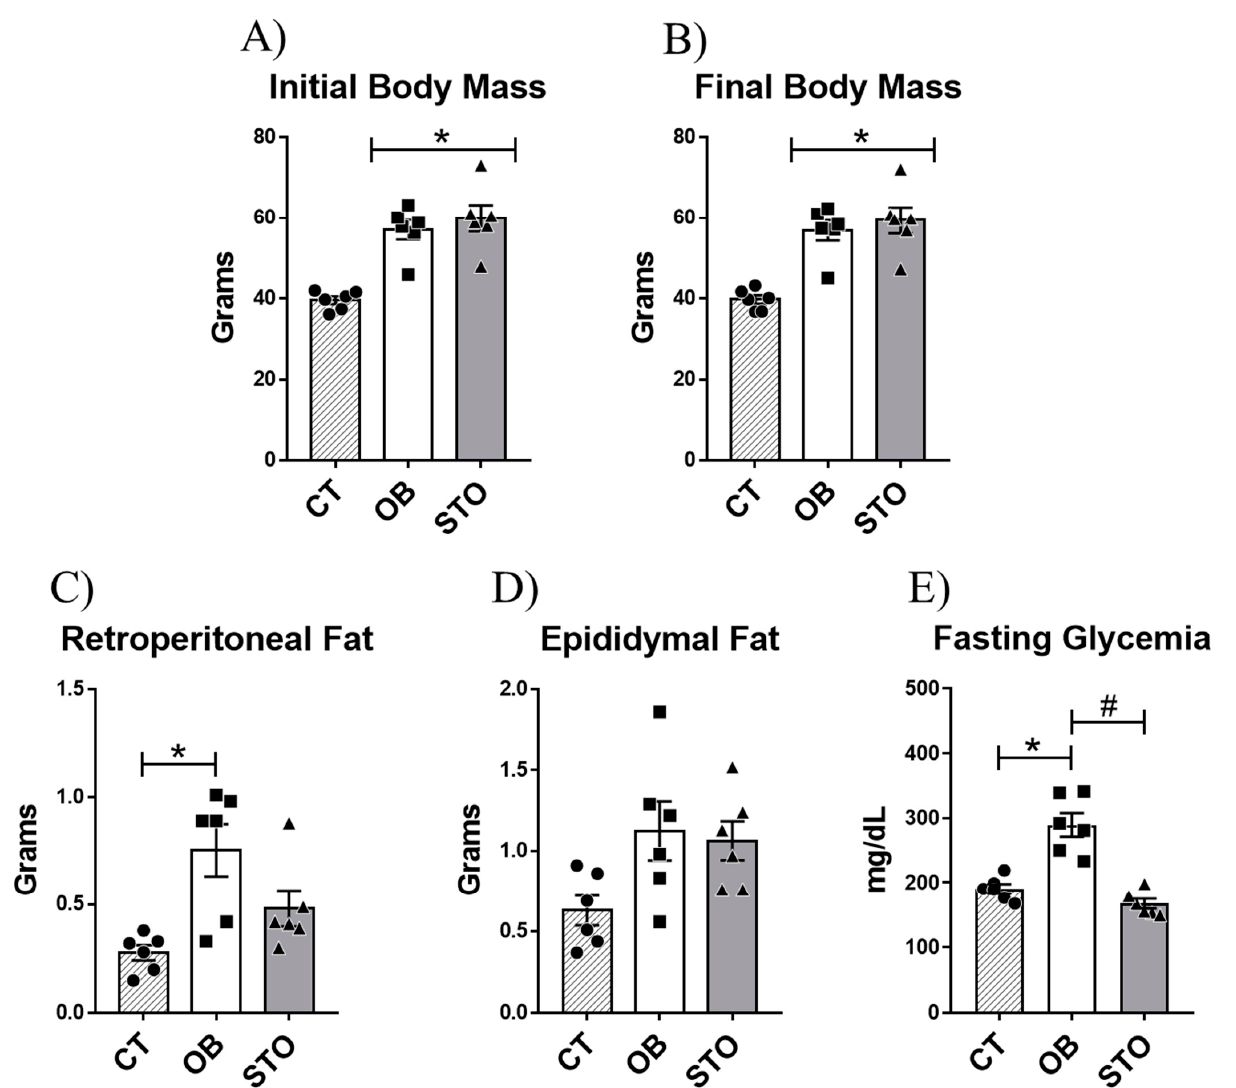
Figure 1. Physiological parameters. Initial body mass: body weight of the animals after diet-induced obesity protocol and before starting the exercise protocol ( A ), Final body mass: body weight of the animals after short-term strength exercise protocol (15 exercise sessions) and before euthanasia ( B ), Retroperitoneal fat ( C ), Epididymal fat ( D ), and Fasting glycemia ( E ). n = 6 per group. CT = Control group; OB = Obese Sedentary Group and STO = Strength Training Obese. * p < 0.05 vs. CT; # p < 0.05 vs. OB ( n = 6 per